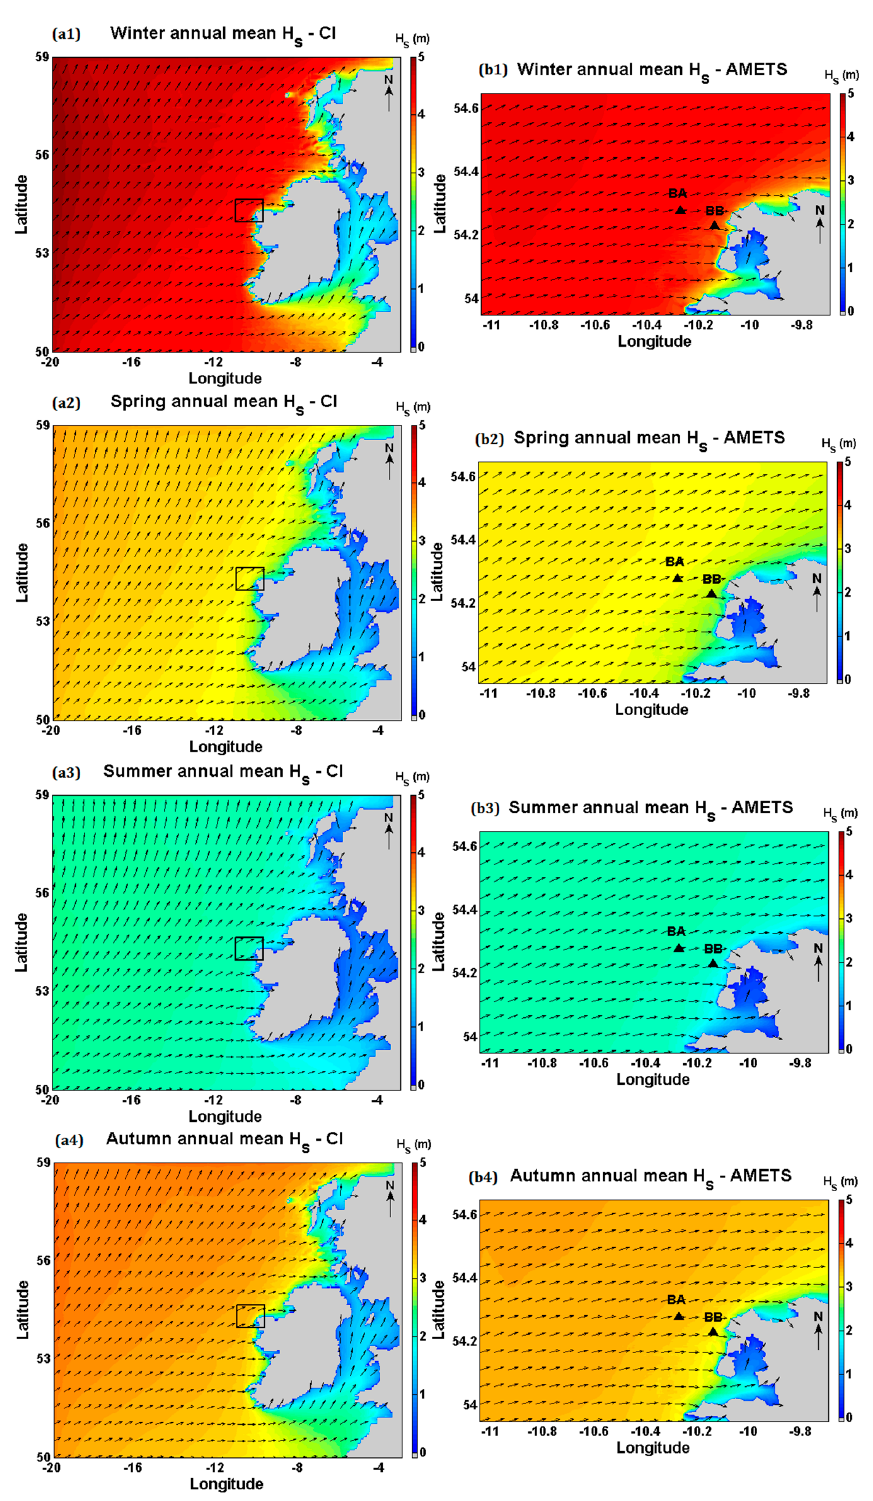
Figure 6. 12-year seasonal means of H s (m) and MWD for ( a1 – a4 ) CI model and ( b1 – b4 ) AMETS model.